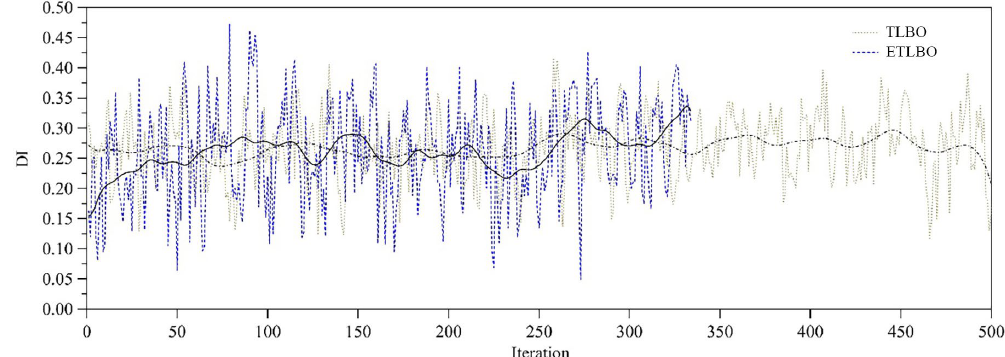
Figure 17. DI traces of ETLBO vs. TLBO for the 1152-bar double layer space frame